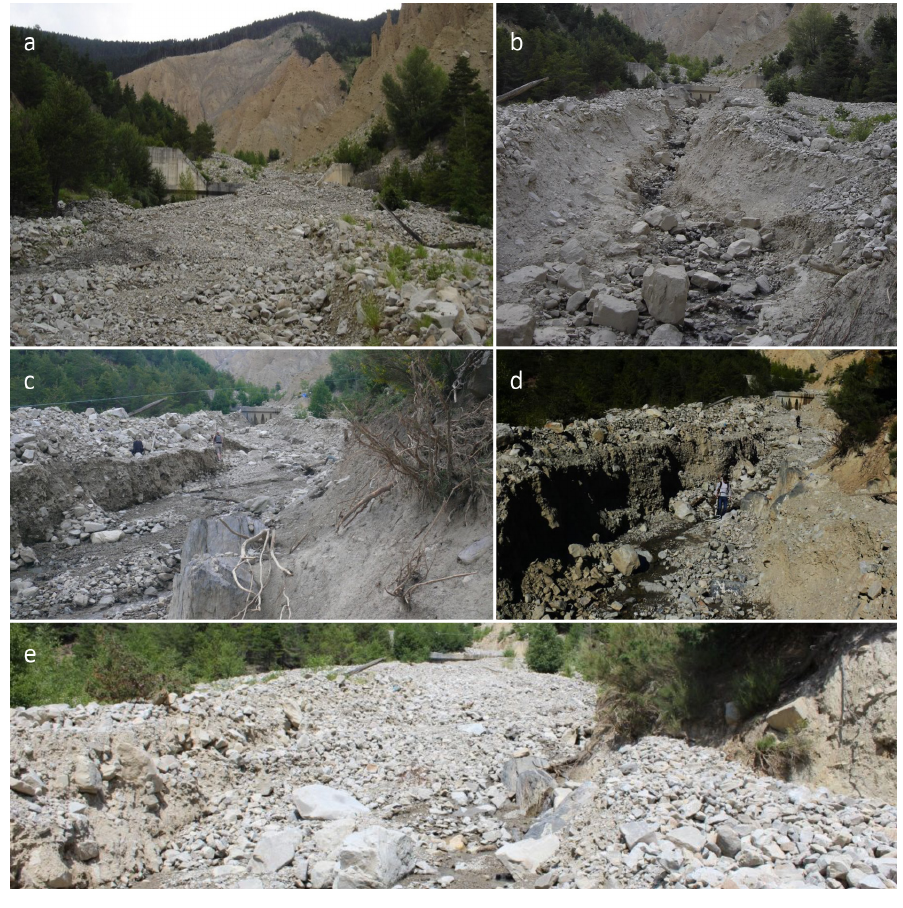
Figure 8. Pictures taken at station S 1 over 6 years: (a) channel filled in June 2009, (b) channel deeply incised in July 2011, (c) channel widened and partially refilled in June 2014 (person for scale), (d) channel further incised in October 2014 (person for scale), and (e) channel refilled in July 2014 (pictures from the authors; Guillaume Piton).